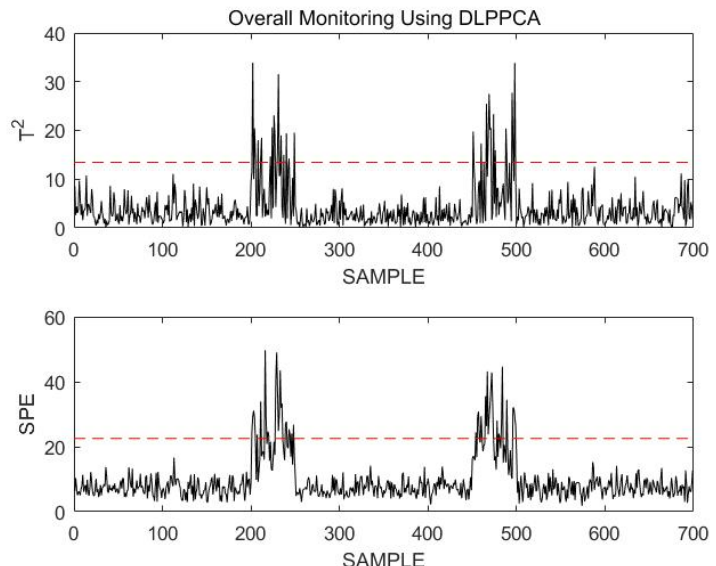
Figure 22. Overall monitoring using DLPPCA.